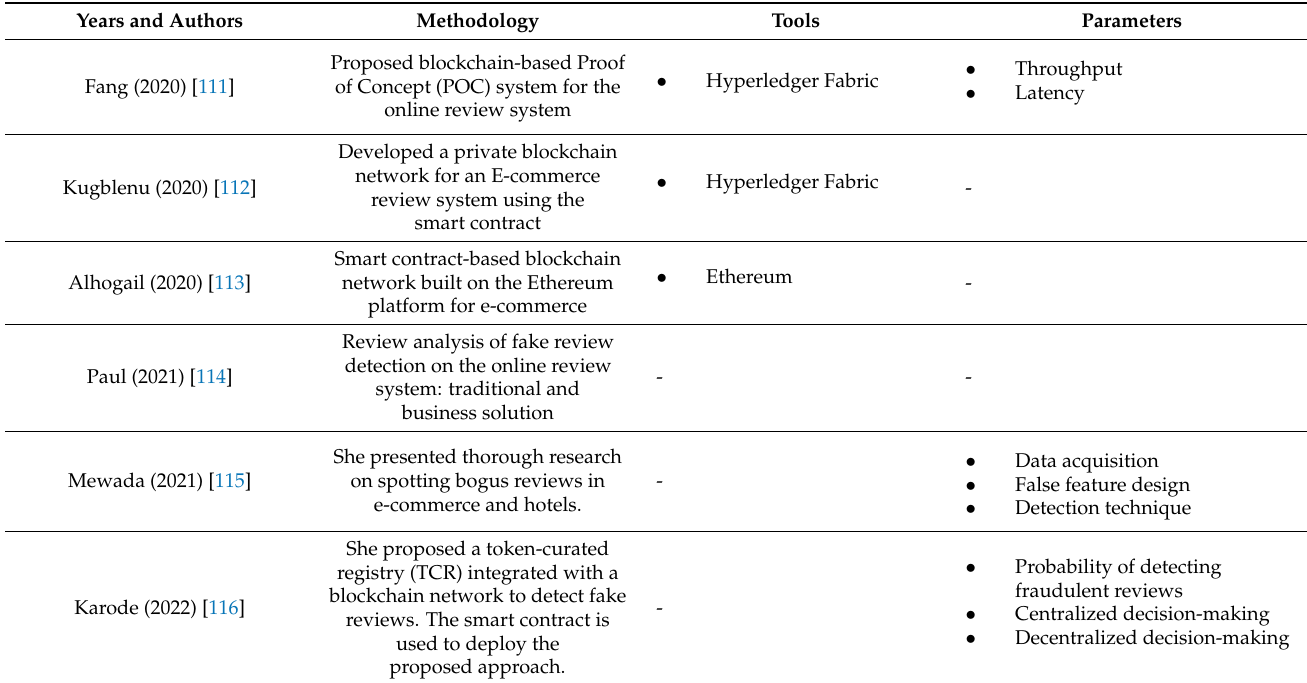
Table 2. Blockchain-based customer review studies published between 2020 and